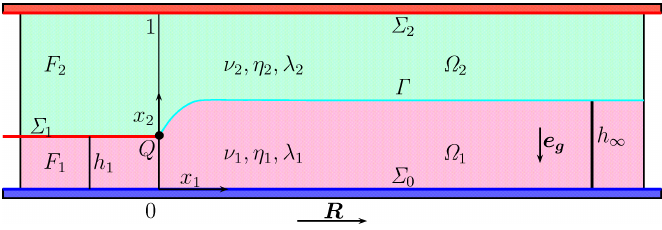
Fig. 1. Flow domain of a two-fluid channel